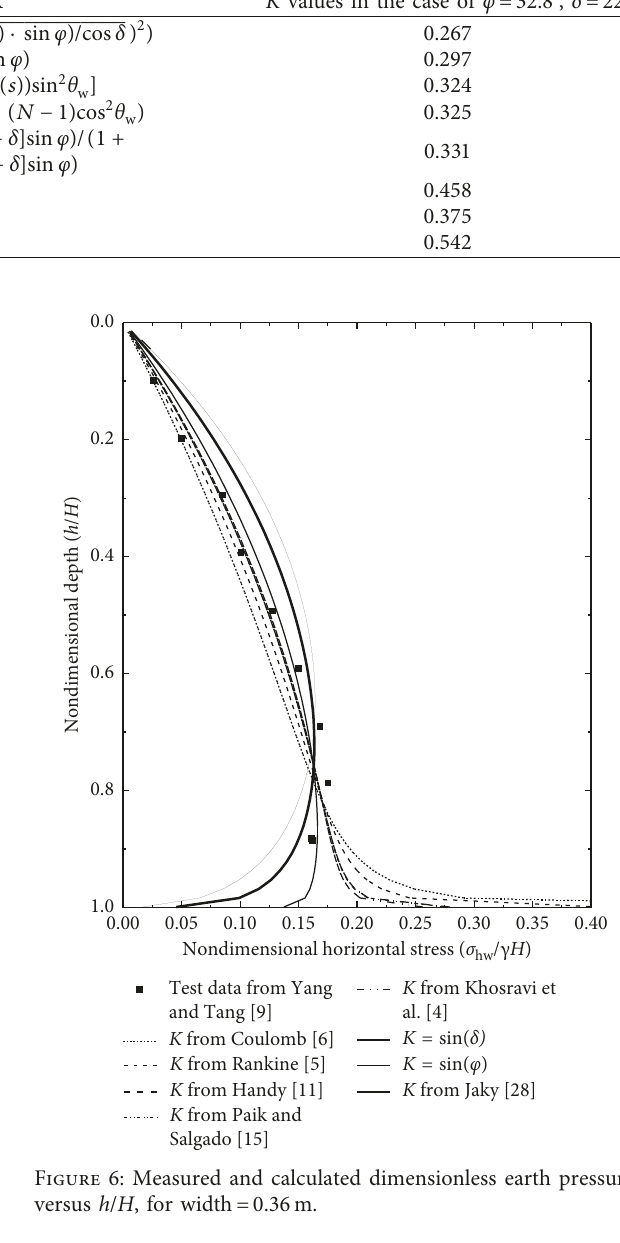
Figure 5: Measured and calculated dimensionless earth pressure versus h / H , for width � 0.56m.